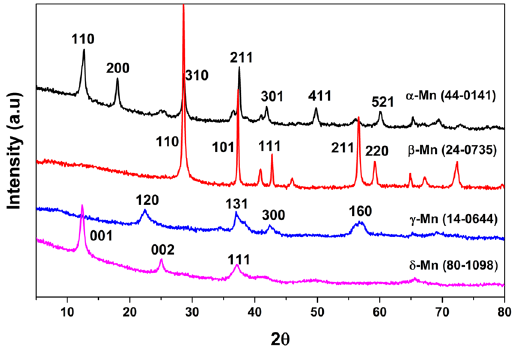
Figure 1. XRD patterns of α -, β -, γ - and δ -MnO 2 samples.